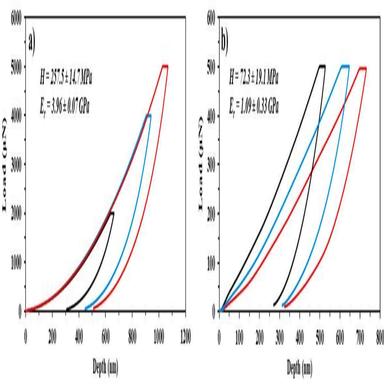
Typical load-displacement curves of (a) ATSP matrix and (b) directly on the capsules embedded in the ATSP matrix. Calculated mean and ±1 standard deviation H and Er are also shown.